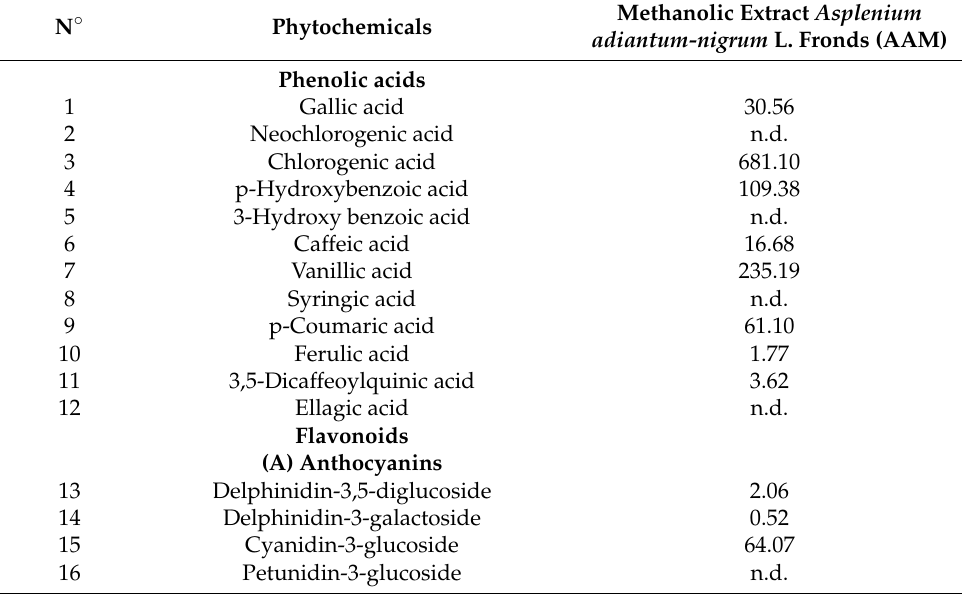
Table 1. Content (mg/kg of dry extract) of 38 phenol phytochemicals in the methanolic extract of Asplenium adiantum-nigrum L. fronds analysed by HPLC-MS/MS ( n = 3, RSD% ranged from 1.8 to